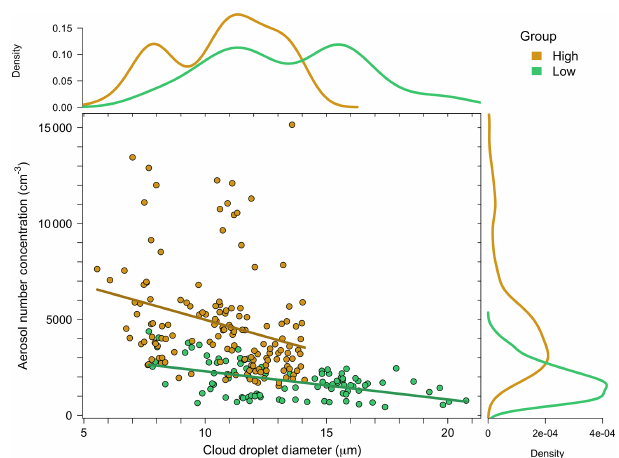
Figure 4. Shows cloud droplet diameter (µm) on the x axis and aerosol number concentration (cm − 3 ) on the y axis, with low- pollution data in green and high-pollution data in gold. The cor- responding density curves of the high- and low-pollution data are given on the outer margins of the plot.